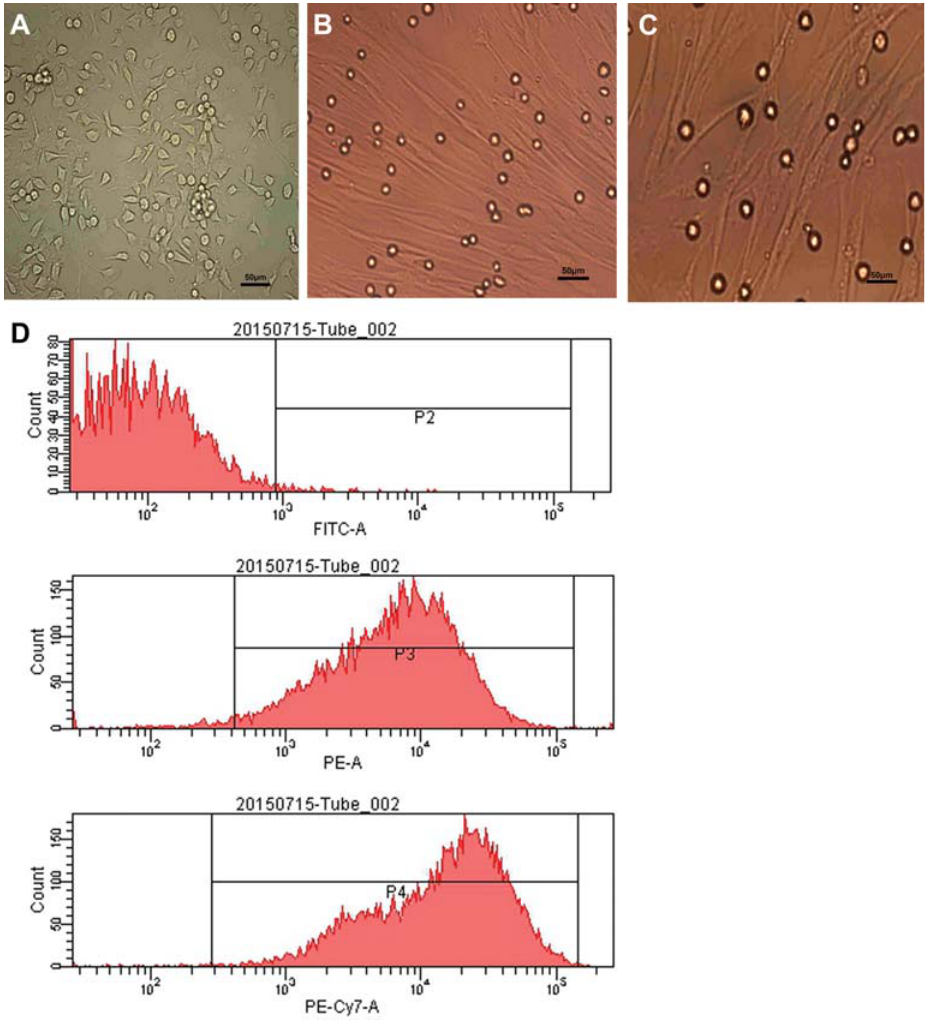
Figure 1. Morphologic change of rat bone marrow mesenchymal stem cells (rBMSCs). A , rBMSCs cultured on day 7; B , rBMSCs treated with 5 ng/mL TGF- b 1 on week 4; C , rBMSCs treated with 10 ng/mL TGF- b 1 on week 4; D , fl ow cytometry identi fi cation of rBMSCs. Magni fi cation bar: 50 m